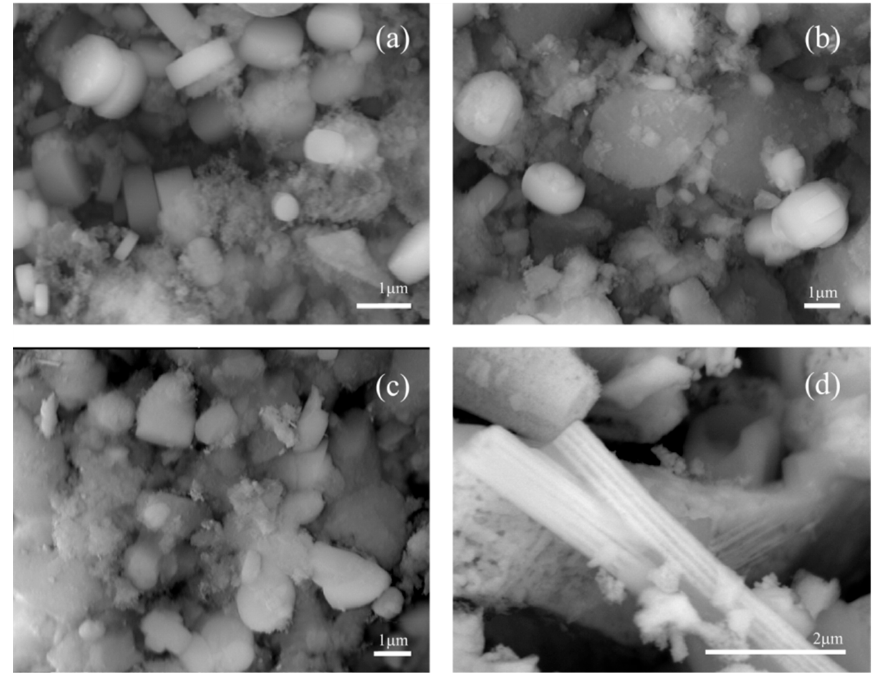
Figure 3. Scanning electron microscopy (SEM) images of the studied samples ( a ) MFI-40, ( b ) MFI-45, ( c ) MFI-50 and ( d ) Zeolyst.